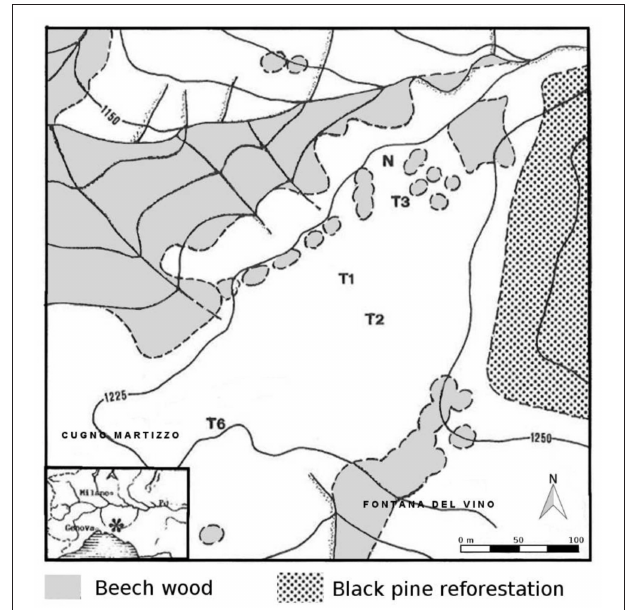
FIGURE 5 | Localization of sample sites in Guido et al. (2002). Signale by “ ∗ ” the site localation.